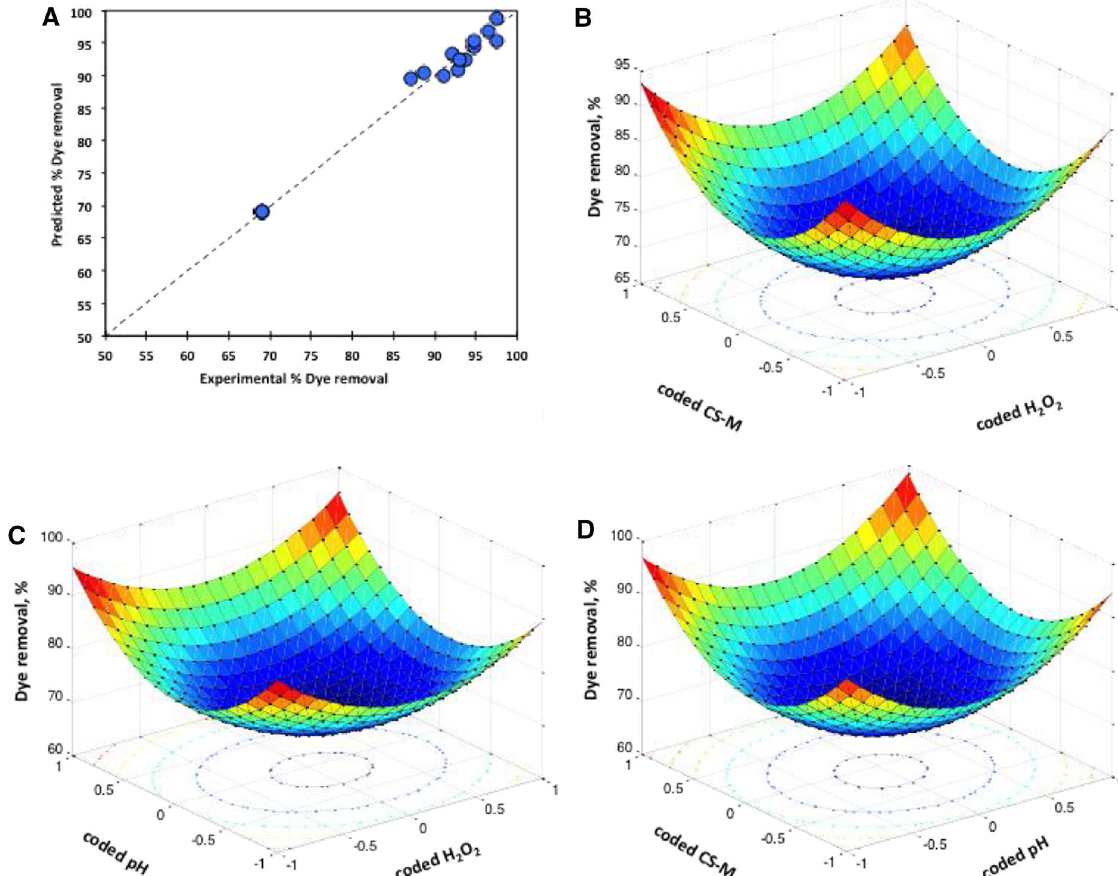
Fig. 7 Optimizing Fenton oxidation based on CS-M system A Exper- imental versus predicted responses plot for BB9 oxidation; B 3-D surface and 2D-contour plot of H 2 O 2 concentration and CS-M; C 3D